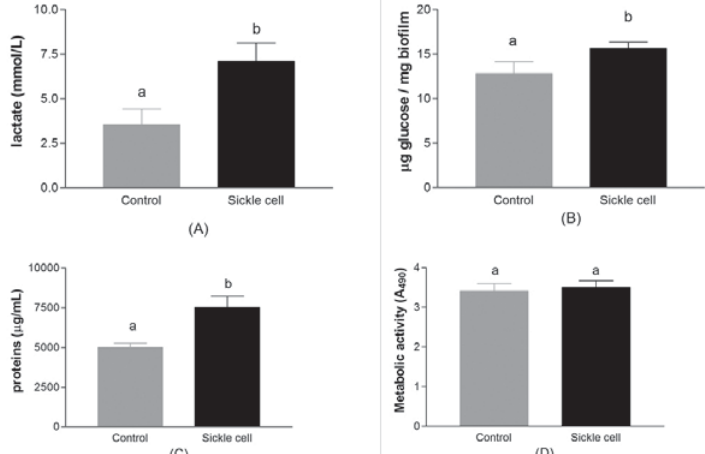
Figure 1- Cariogenicity of C. albicans (cid:3)(cid:69)(cid:76)(cid:82)(cid:191)(cid:79)(cid:80)(cid:86)(cid:3)(cid:76)(cid:86)(cid:82)(cid:79)(cid:68)(cid:87)(cid:72)(cid:71)(cid:3)(cid:73)(cid:85)(cid:82)(cid:80)(cid:3)(cid:70)(cid:75)(cid:76)(cid:79)(cid:71)(cid:85)(cid:72)(cid:81)(cid:3)(cid:90)(cid:76)(cid:87)(cid:75)(cid:3)(cid:86)(cid:76)(cid:70)(cid:78)(cid:79)(cid:72)(cid:16)(cid:70)(cid:72)(cid:79)(cid:79)(cid:3)(cid:71)(cid:76)(cid:86)(cid:72)(cid:68)(cid:86)(cid:72)(cid:3)(cid:68)(cid:81)(cid:71)(cid:3)(cid:87)(cid:75)(cid:72)(cid:76)(cid:85)(cid:3)(cid:80)(cid:68)(cid:87)(cid:70)(cid:75)(cid:72)(cid:71)(cid:3)(cid:75)(cid:72)(cid:68)(cid:79)(cid:87)(cid:75)(cid:92)(cid:3) controls (n=25 isolates per group). A) Concentration of lactic acid (mmol/L-1); B) Concentration of alkali-soluble (cid:83)(cid:82)(cid:79)(cid:92)(cid:86)(cid:68)(cid:70)(cid:70)(cid:75)(cid:68)(cid:85)(cid:76)(cid:71)(cid:72)(cid:86)(cid:3)